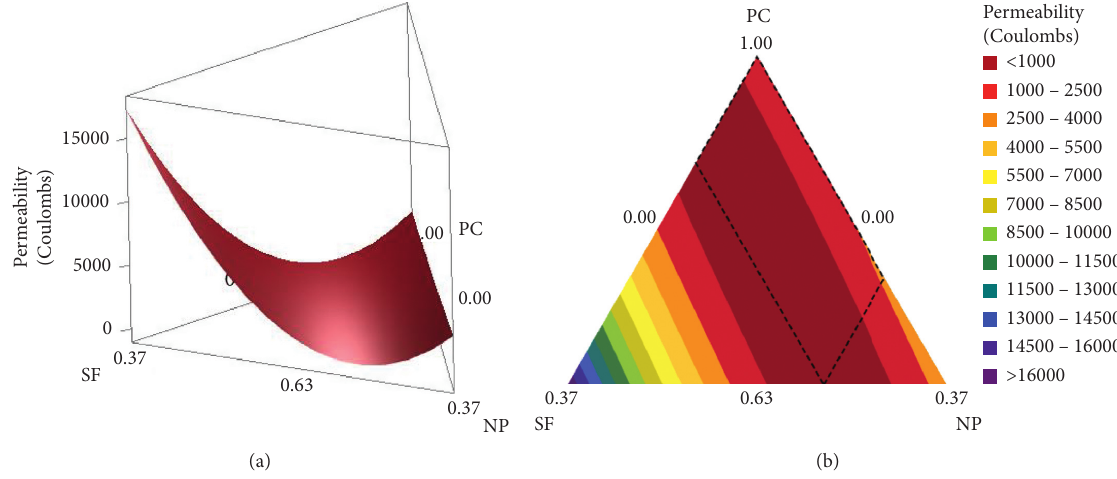
Figure 10: Permeability isoresponse of concrete that incorporates a blend of binders ( w / b ) � 0.25). (a) Surface. (b)